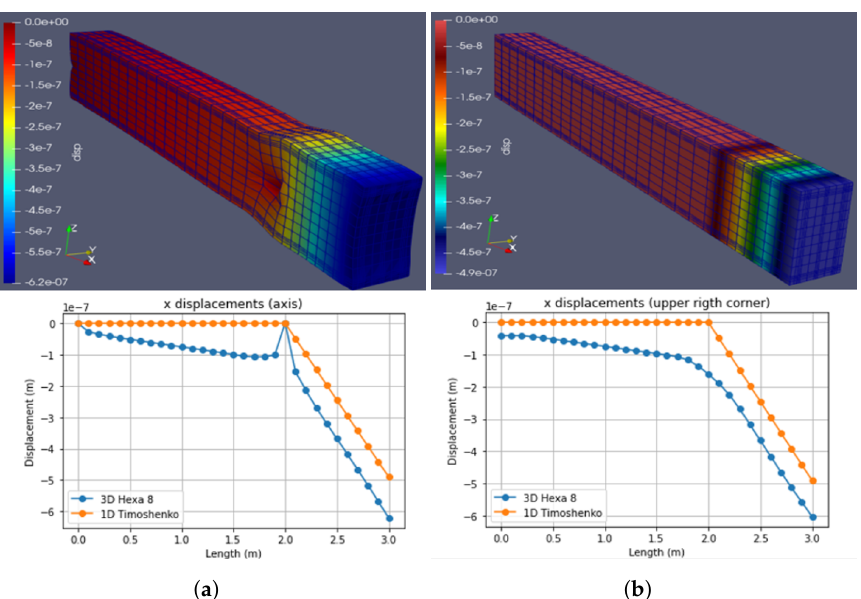
Figure 19. Case 6: Compression load at L = 3 m (Fx = − 1000 N.m). ( a ) Hexa8. ( b ) Timoshenko. (Note: e − n indicates 10 − n